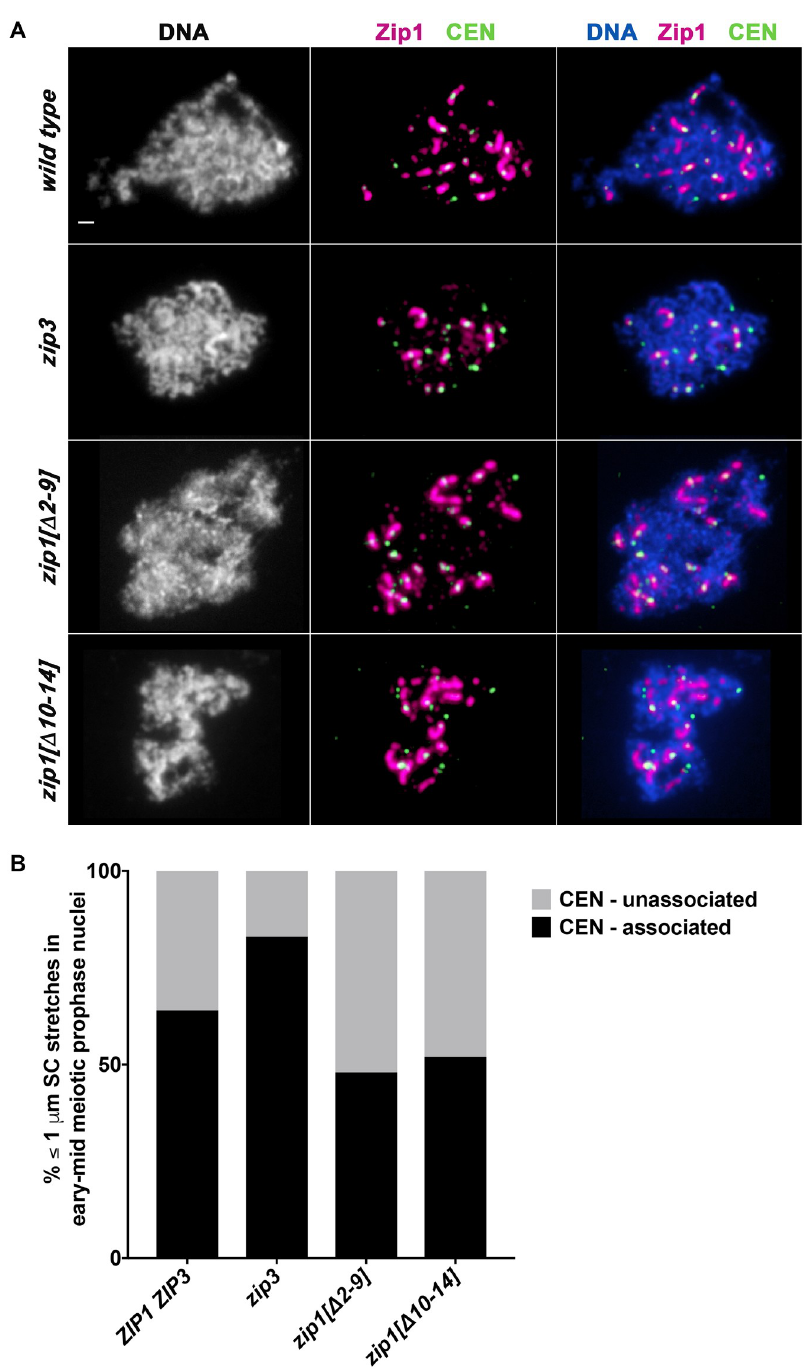
Fig 7. SC comprised of Zip1[ Δ 2–9] or Zip1[ Δ 10–14] protein initiates at both centromeric and non-centromeric chromosomal sites. A) Representative surface-spread meiotic nuclei from wild-type (AM4203; top row), zip3 (AM4204; second row), zip1[ Δ 2–9] (AM4231; third row) or zip1[ Δ 10–14] (AM4175; bottom row) strains producing the centromere-associated Ctf19-MYC protein. Surface-spread nuclei are labeled with DAPI-labeled DNA (white), anti-Zip1 (magenta), and anti-MYC (green). While all strains at this early stage of synapsis exhibit a large number of short Zip1 assemblies associated with a centromere, fewer examples of � 1 μ m Zip1 assemblies without an associated centromere were observed in zip3 strains, relative to wild-type, zip1[ Δ 2–9] or zip1[ Δ 10–14] strains. Scale bar, 1 μ m. Quantitation of the number of � 1 μ m Zip1 assemblies with or without an associated Ctf19-MYC signal is shown in the bar graphs in (B) , where light shading represents the percentage of total � 1 μ m Zip1 assemblies in each strain that